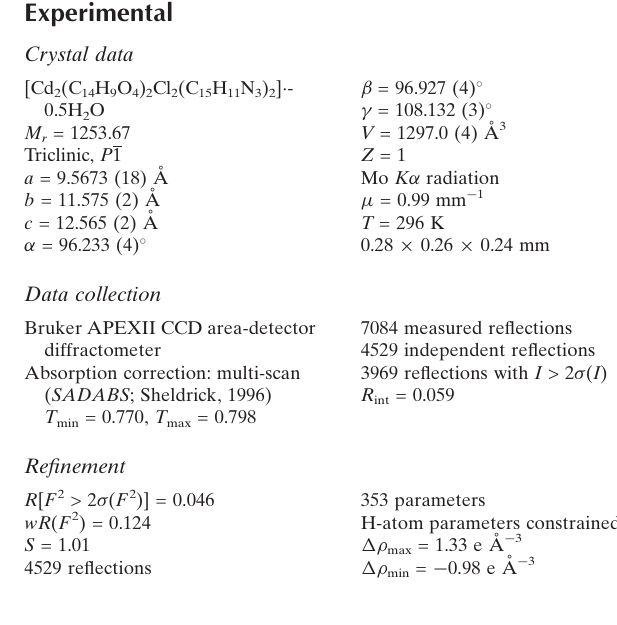
disorder in solvent or counterion; R factor = 0.046; wR factor = 0.124; data-to-